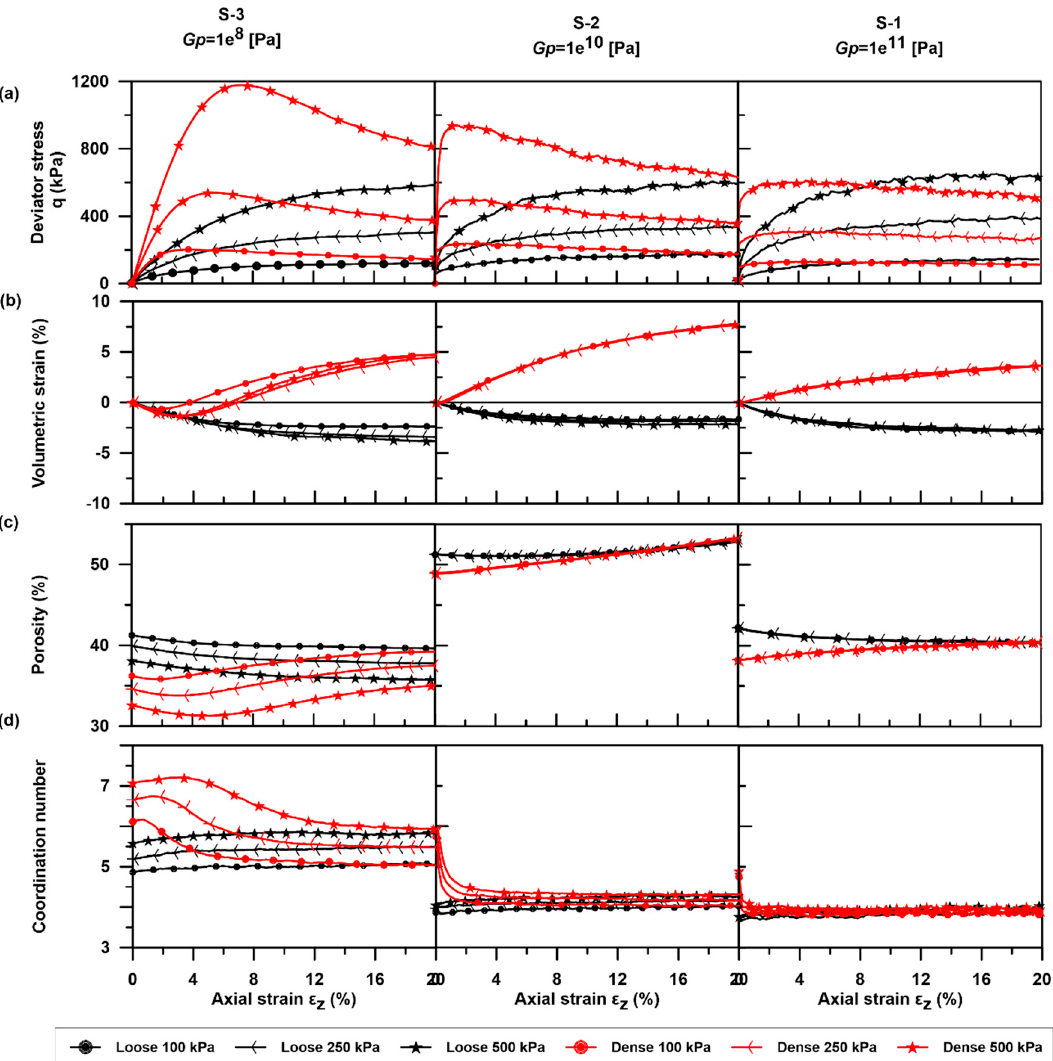
Figure 3. Triaxial tests results for ‘sand’ samples presented as ( a ) the deviator stress, ( b ) the volumetric strain, ( c ) the porosity and ( d ) the coordination number over the axial strain; the micro-shear modulus ( 𝐺 (cid:3043) ) is increasing from left to right. Black lines represent loose packed samples and red lines represent dense packed samples. Each confining stress is represented by a different symbol for 100, 250 and 500 kPa.